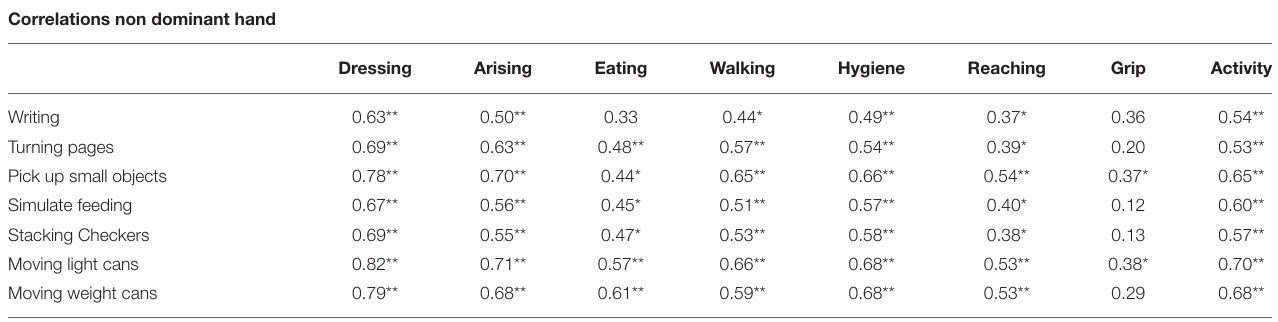
TABLE 3 | Pearsons’ correlation coefficient for nondominant hand between the Jebsen Taylor Hand Function Test (JTHFT) and the Health Assessment Questionnaire (HAQ). Correlations non dominant hand